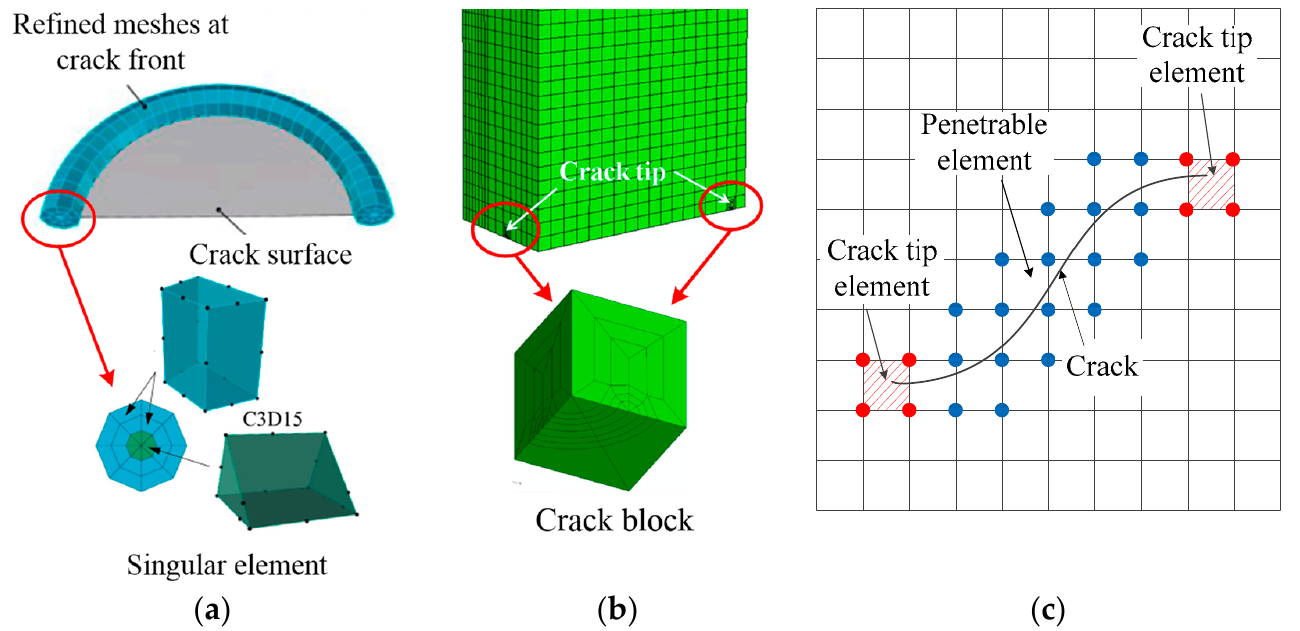
Figure 1. Meshing at the crack tip in different numerical simulation methods. ( a ) ANSYS [25]; ( b ) ZENCRACK [30]; ( c ) XFEM [28].